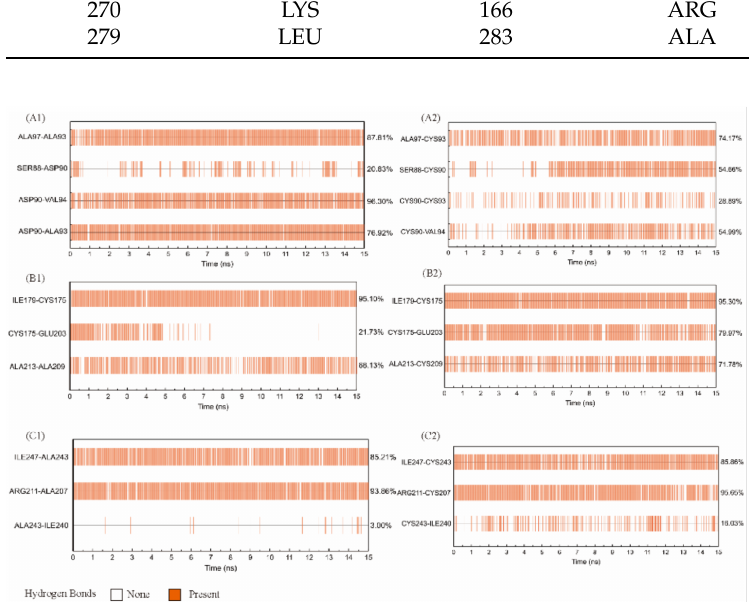
Figure A1. Hydrogen-bond existence map around residues D90/A93 (A1), C175/A209 (B1) and A207/A243 (C1) residues in wild-type DPEase and the cysteine-substituted mutants D90C-A93C (A2), C175-A209C (B2) and A207C-A243C (C2) along the analyzed time frames. Red lines show the presence of a hydrogen bond at that specific time and white breaks imply the absence of that hydrogen